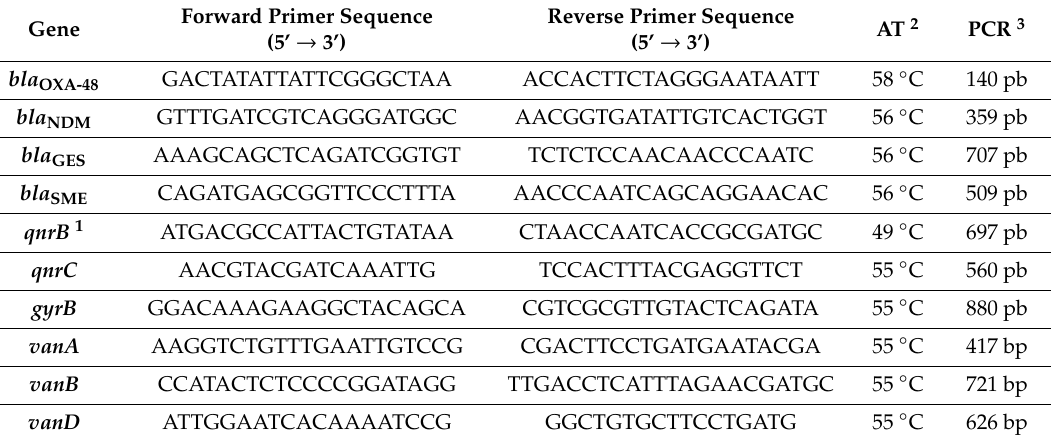
Table 3. Primers used in the detection of resistance genes that were described in this study for the first time.